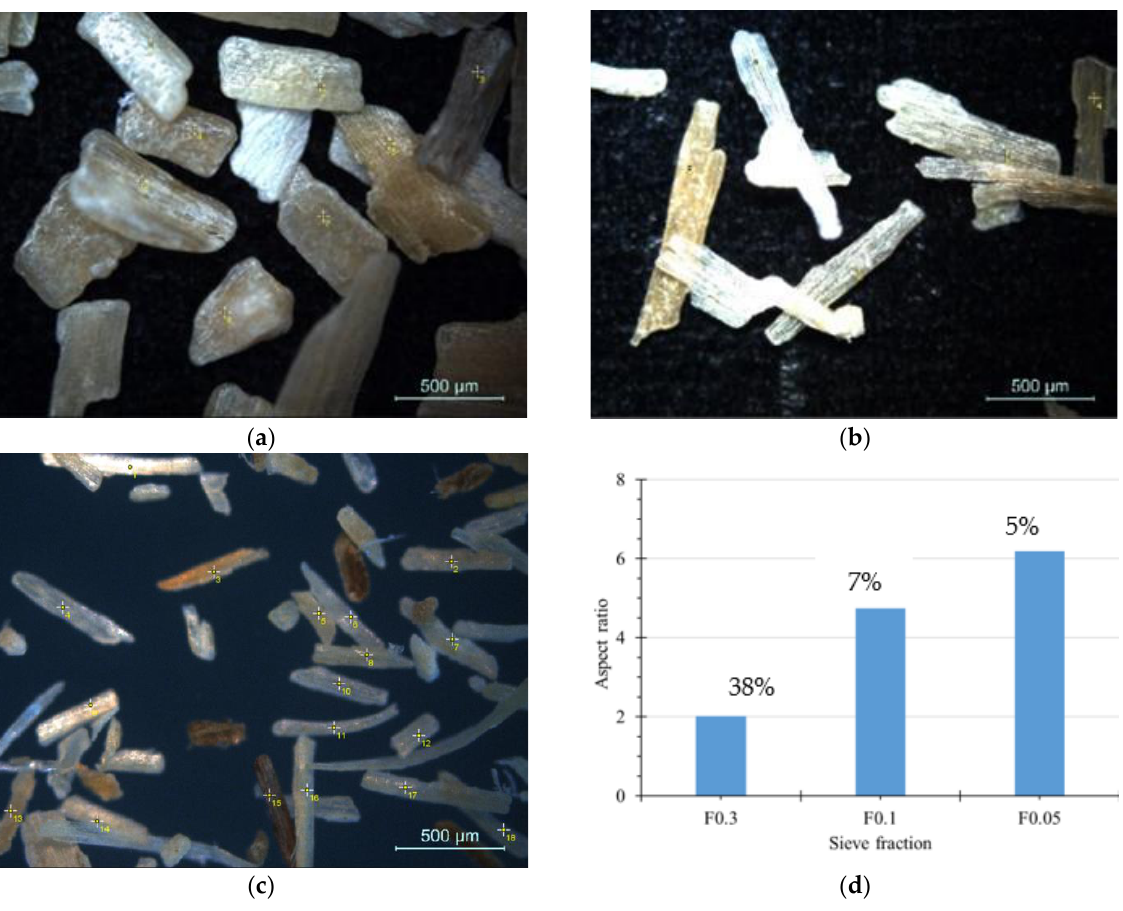
Figure 2. Light microscopy images of SH after sieving through 0.5 mm ( a ), 0.3 mm ( b ), and 0.1 mm ( c ); size sieves and calculated average aspect ratios of the respective sieve fractions and their per cent amounts ( d ).